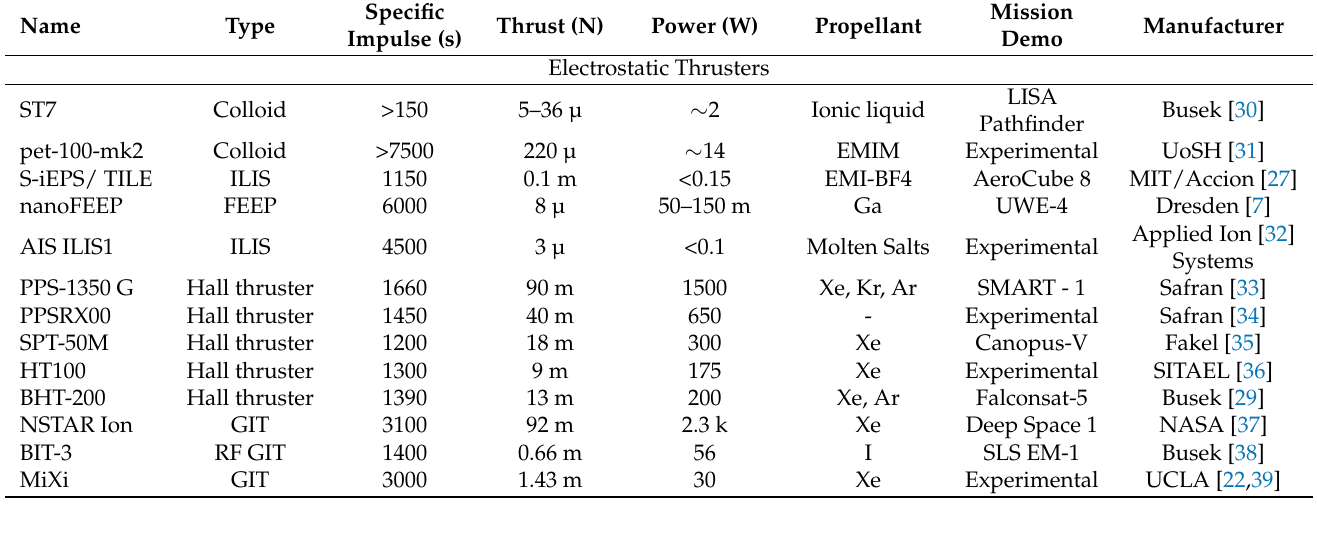
Figure 2. Electrostatic thruster examples: ( a ) NanoFEEP thrusters integrated into the rails of the flight model of the UWE-4 CubeSat, size 3 cm 3 [7], ( b ) S-iEPS propulsion module electrospray microthruster, size [14.4 × 14.4 × 14.1] mm [27,28], ( c ) Halo is a miniaturised center line-cathode Hall thruster, size 7.5 cm in diameter credit: ExoTerra Resource LLC and ( d ) BIT-3, the world’s first iodine-fueled gridded ion thruster, size 2.5 cm in diameter [29]. Table 1. Examples of electrostatic thruster parameters.